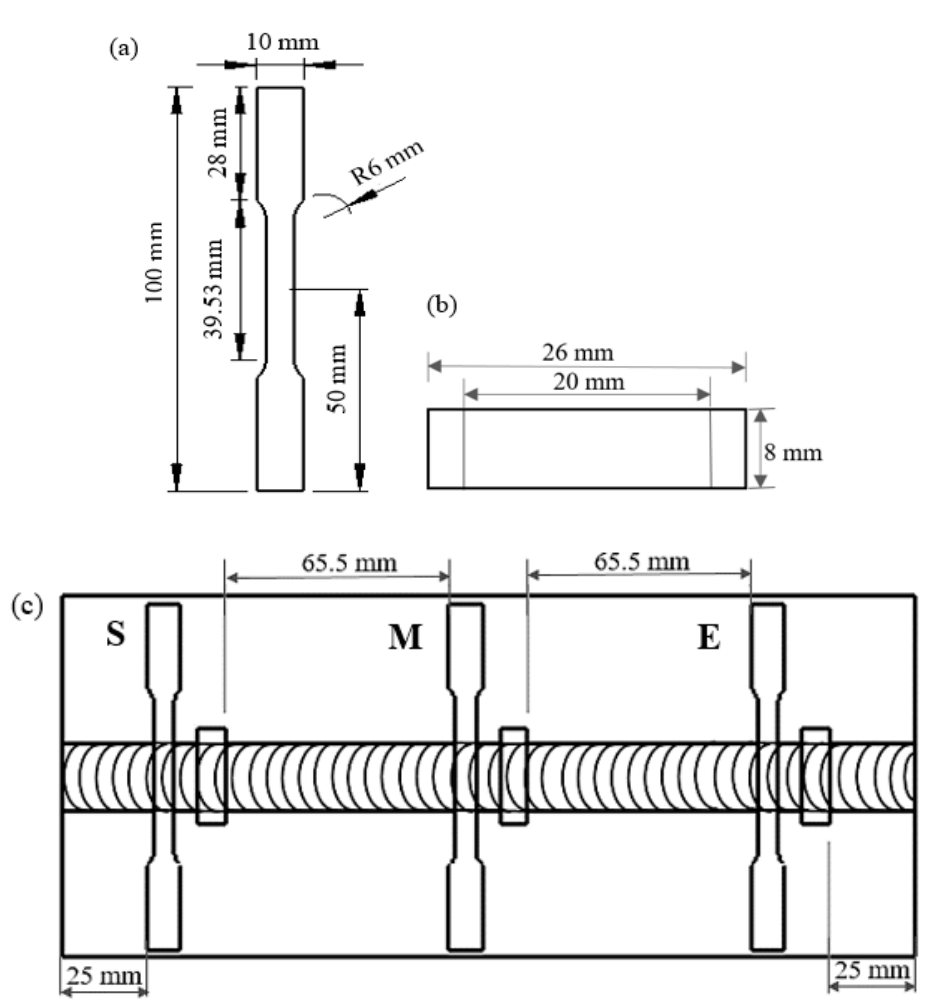
Figure 2. ( a ) Tensile specimen, ( b ) hardness and microstructure specimen, ( c ) specimen positioning diagram.